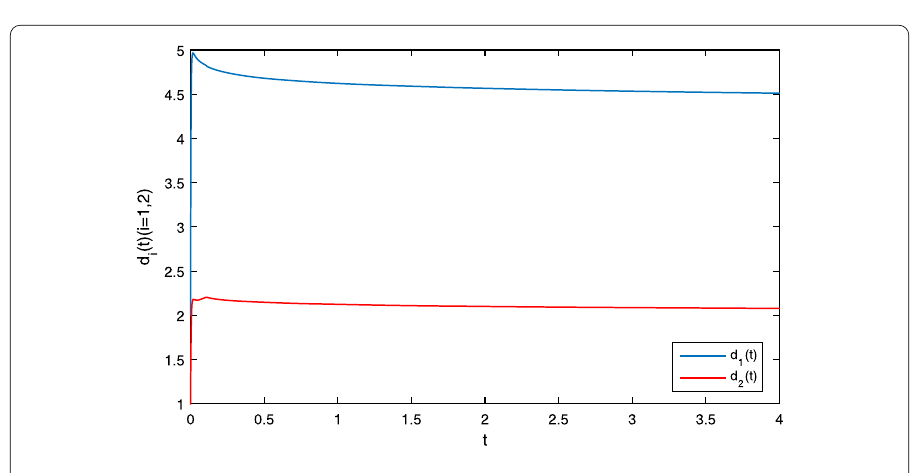
Figure 15 Time response of d i ( t ) ( i = 1,2) with β =